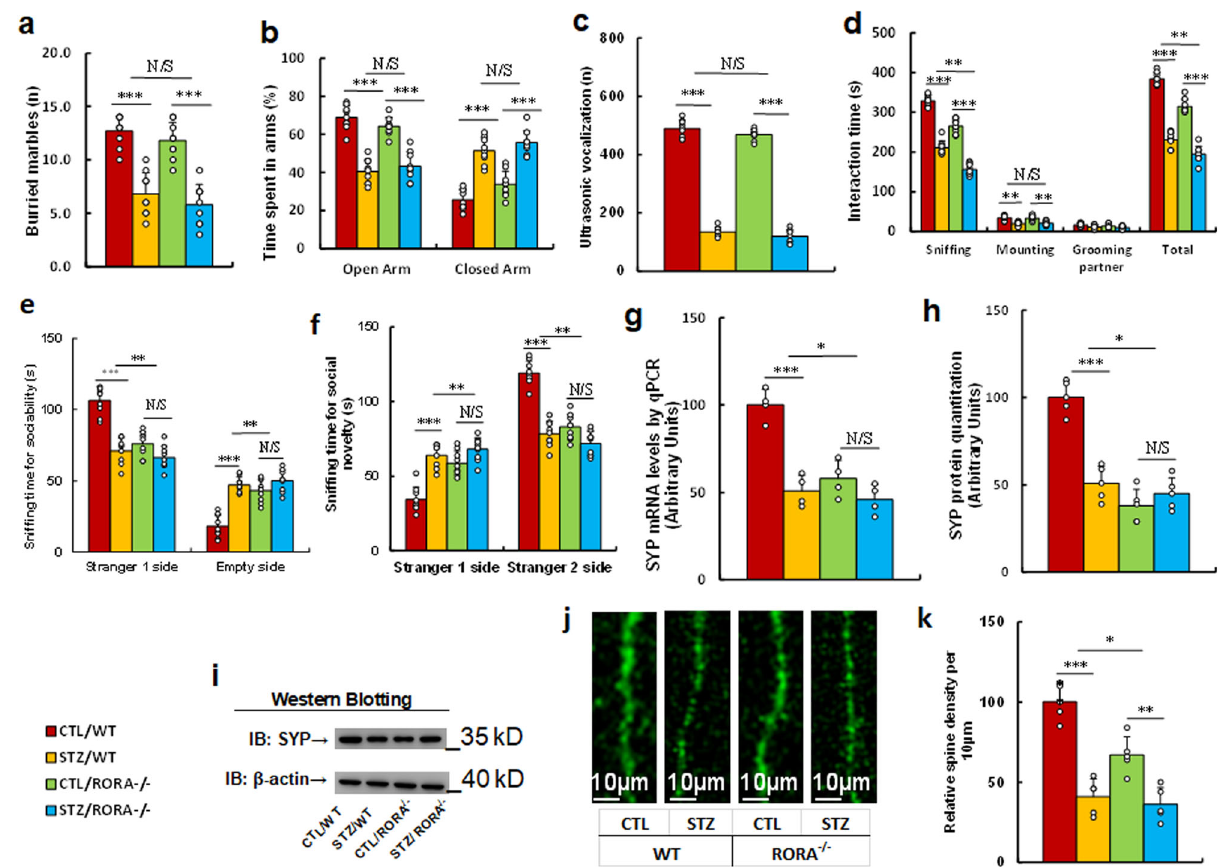
Fig. 5 Prenatal RORA de fi ciency potentiates maternal diabetes-mediated autism-like behavior, while it has little effect on anxiety-like behavior in offspring. The RORA wild type (WT) or RORA null (RORA − / − ) background were used to generate either control (CTL) or STZ-induced diabetic (STZ) pregnant dams, and the subsequent 7- to 8-week-old male offspring were used for animal behavior analysis. a Marble-burying tests (MBT), n = 9. b Time spent in Open Arm and Closed Arm in the EPM test, n = 9. c Ultrasonic vocalization, n = 9. d Social interaction (SI) test, the time spent in following, mounting, grooming, and snif fi ng any body parts of the other mouse, and in total was calculated, n = 9. e , f Three-chambered social tests, n = 9. e Time spent in the chamber for sociability. f Time spent in the chamber for social novelty. g SYP mRNA level by qPCR, n = 4. h SYP protein quantitation, n = 5. i The representative pictures for western blotting for ( h ). j Representative images of dendritic spines in the amygdala. k Quantitative data of spine density, n = 5. ***, P < 0.0001; **, P < 0.001; *, P < 0.01; N/S no signi fi cance. Data were expressed as mean ±